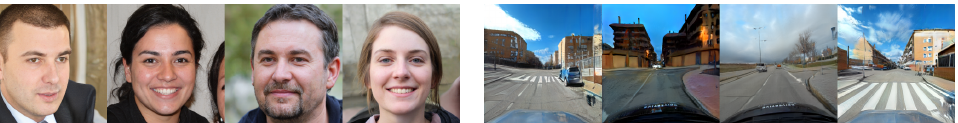
Figure 13. On the left, an example of the performances of StyleGAN-2. On the right, an example of the output of the StyleGAN-2-ADA network after 800k epochs. The number of face images in the FFHQ [38] dataset is impressively high in comparison with the few sequences of our combined sequences. For this training, we used all the images available in both Alcalá and KITTI sequences, without any split. However, to avoid presenting too similar images, we decimated the input images to have a constant frame rate equal to 1 fps.